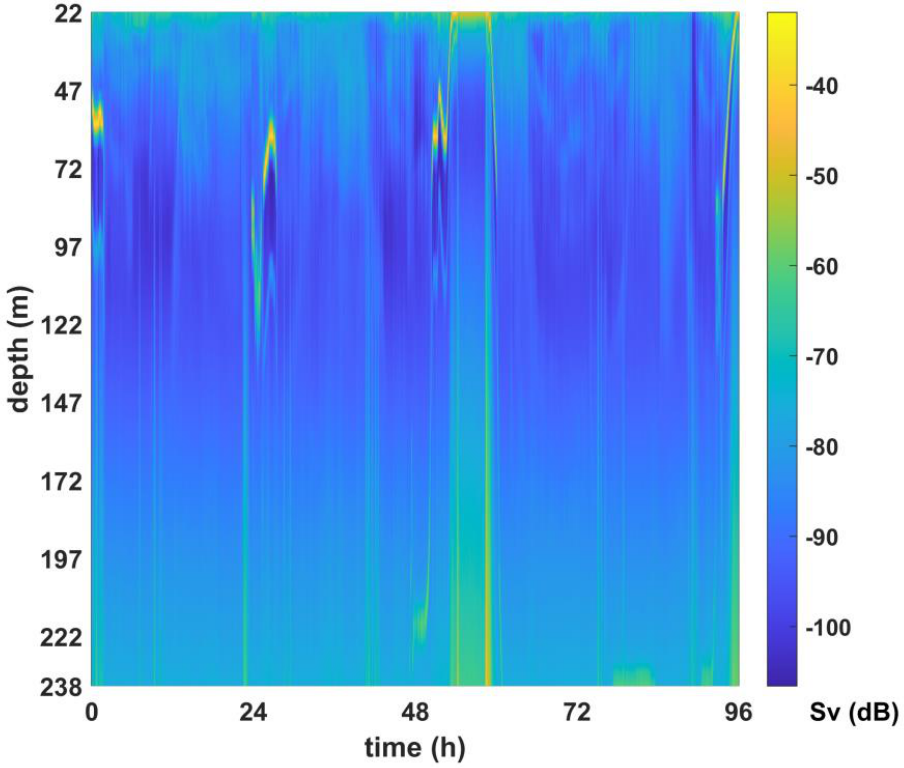
Figure 12. Time series of raw backscatter data profiles acquired along the route during 2017 Cam- paign.